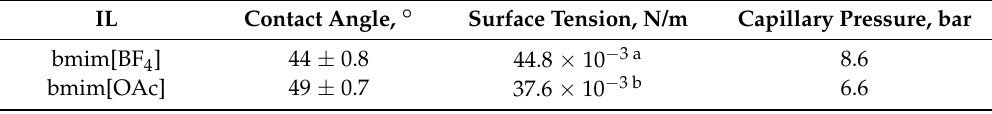
Table 2. Contact angle of ionic liquids on MFFK-1 and calculated capillary pressure.